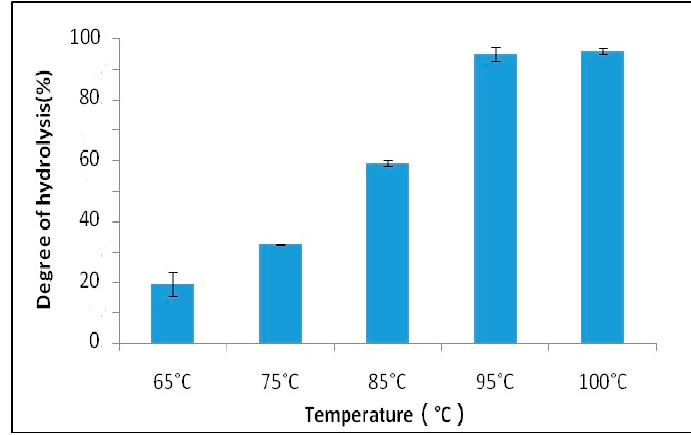
Figure 11. Effect of temperature on the hydrolysis of Schizochytrium sp. oil. (Water to oil ratio = 3:1 (w:w), 1% Sodiumdodecyl-sulfate based on oil weight, 1.4 mol/L sulphuric acid, 750 rpm).